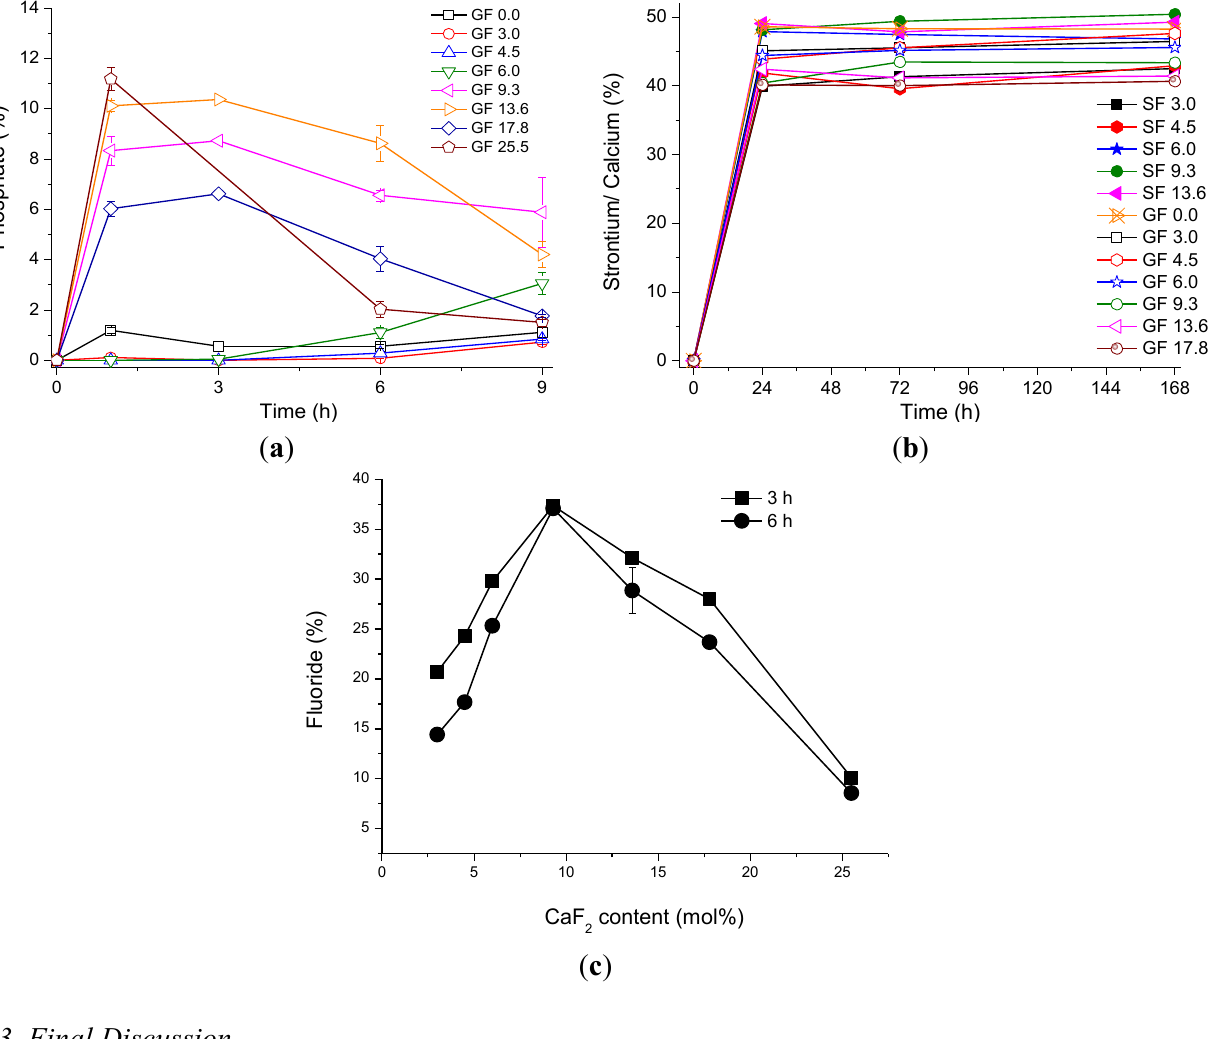
Figure 5. ( a ) The percentage of phosphate presented as concentration of elemental phosphorus in Tris for CaF -containing glasses; ( b ) The percentage of cations (Sr 2+ or Ca 2+ ) 2 concentration in Tris; ( c ) The percentage of fluoride concentration measured at 3 and 6 h in Tris for CaF -containing 2